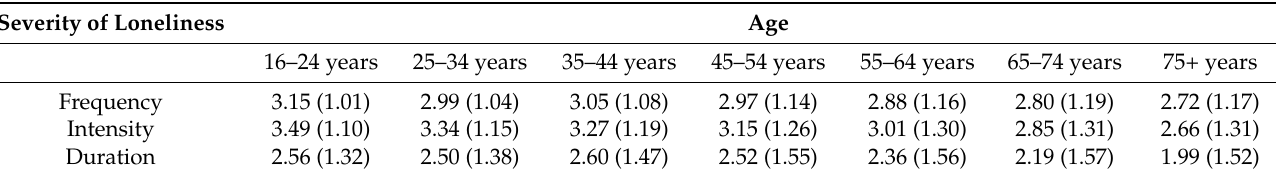
Table 2. Sample means/SDs (by age) for the three different aspects of severity of loneliness. Severity of Loneliness